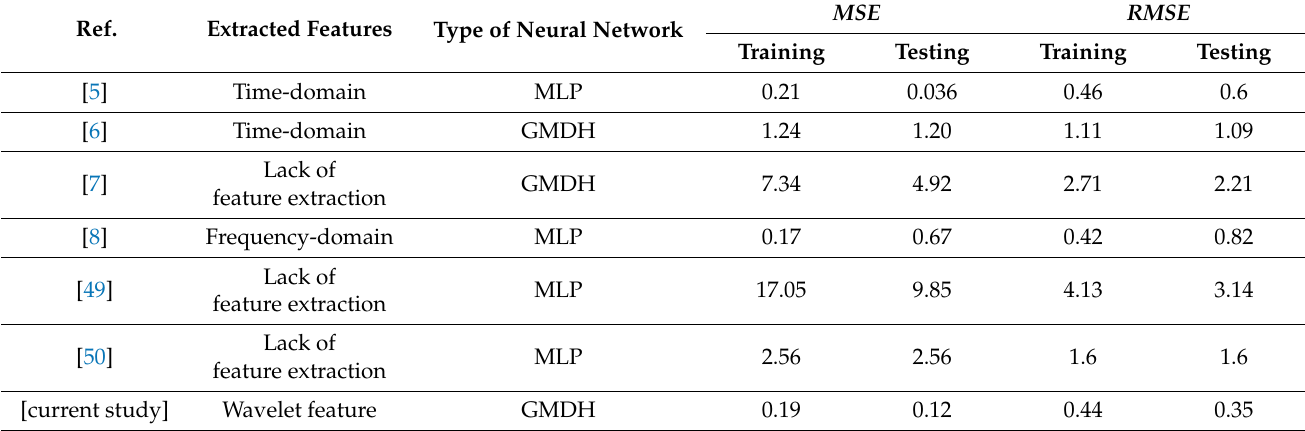
Table 2. A comparison of the accuracy of the proposed detection system and previous studies.